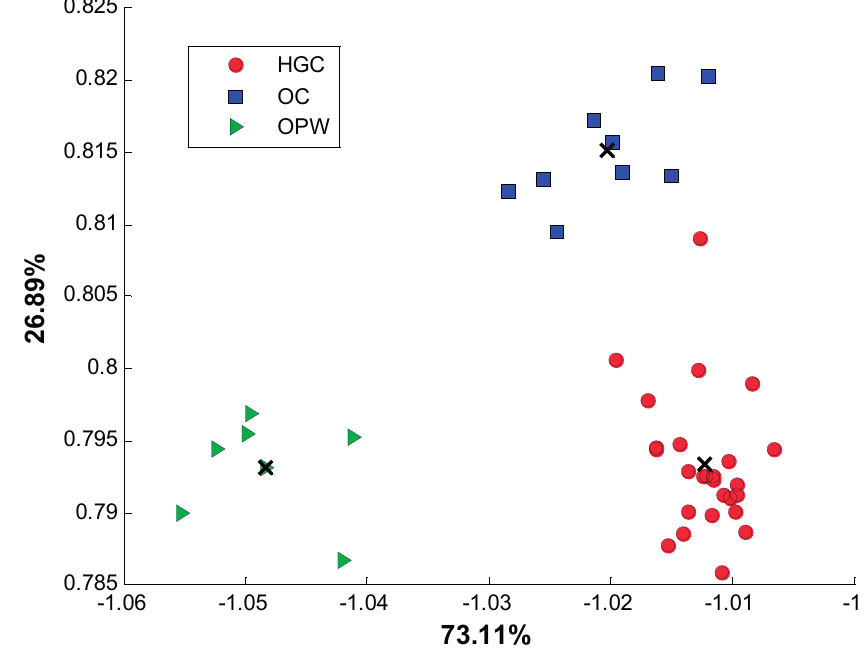
Figure 4. LDA classification according to growing